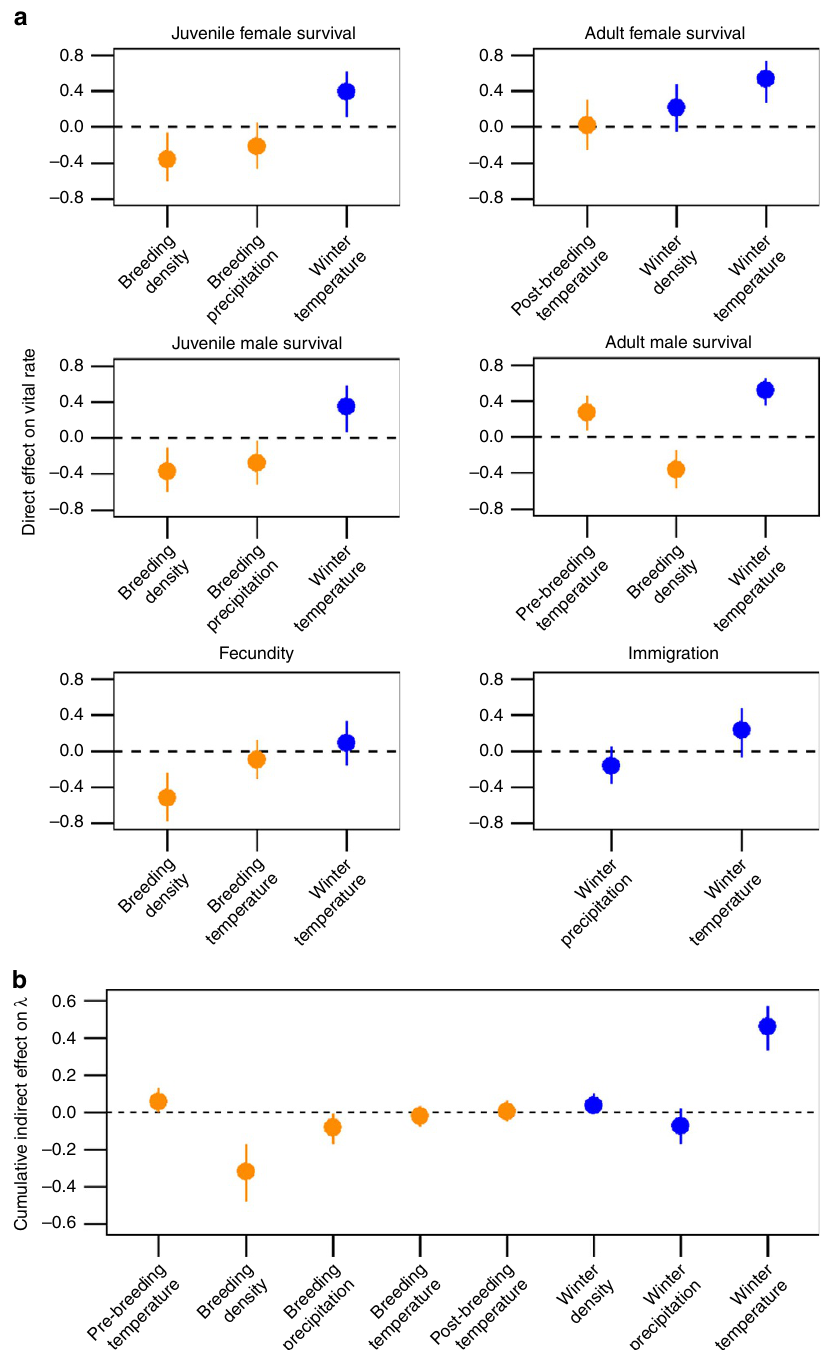
Figure 4 | Effects of weather and density at breeding and population-specific wintering grounds on population growth rate ( k ). ( a ) Direct effects (mean ± 95% credible interval) of weather and density at the breeding (orange) and population-specific wintering grounds (blue) on vital rates. ( b ) Cumulative indirect effects of breeding and winter covariates on population growth rate via the vital rates. The total effect of a given covariate X (for example, winter temperature) on population growth rate was calculated from standardized regression coefficients estimated using path analysis by calculating the indirect effects of covariate X on growth rate via each vital rate and then summing indirect effects across all vital rates. The indirect effect of covariate X on growth rate through a given vital rate V equals the product of the direct effect of vital rate V on growth rate and the direct effect of covariate X on vital rate V components of populations, or periods of the annual cycle, on provisioning young 25 . If fecundity contributes strongly to which targeted conservation actions are likely to have the greatest variation in population growth rate, then the fate of a effect in sustaining populations. For example, warming tempera- population or species may hinge on its ability to cope with, or tures are known to influence some migratory animals by altering adjust to, long-term warming trends and conservation resources their timing of breeding in relation to peak food supply for should be allocated to ensure successful reproduction 26 .